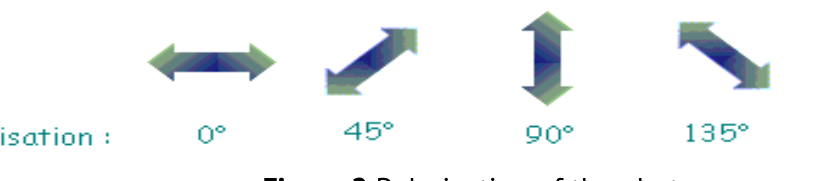
Figure 2 Polarization of the